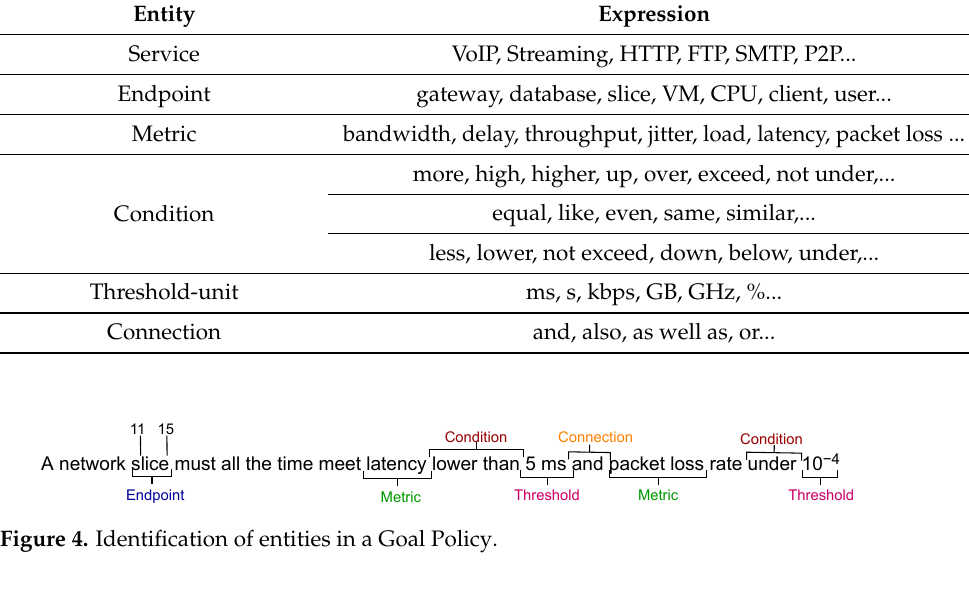
Table 1. Network management grammar.